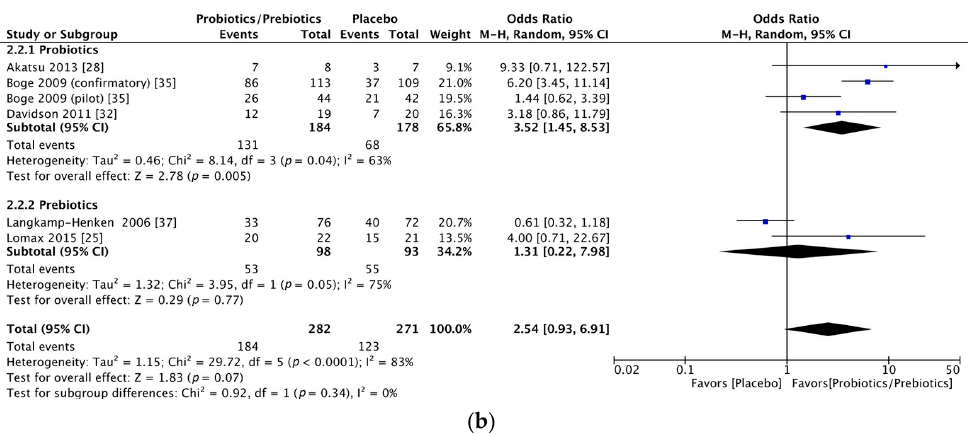
Figure 5. Forest plots of subgroup analysis by intervention type of seroconversion rate of H1N1 and H3N2 strains. ( a ) Forest plot of subgroup analysis by intervention type of seroconversion rate for influenza H1N1 strain; ( b ) Forest plot of subgroup analysis by intervention type of seroconversion rate for influenza H3N2 strain. The bold data represents total participants of all included studies and the Odds ratio (OR) between the probiotics/prebiotics group and the placebo group. The diamond stands for the pooled OR. Weights are from random-effects model. CI: confidence interval.